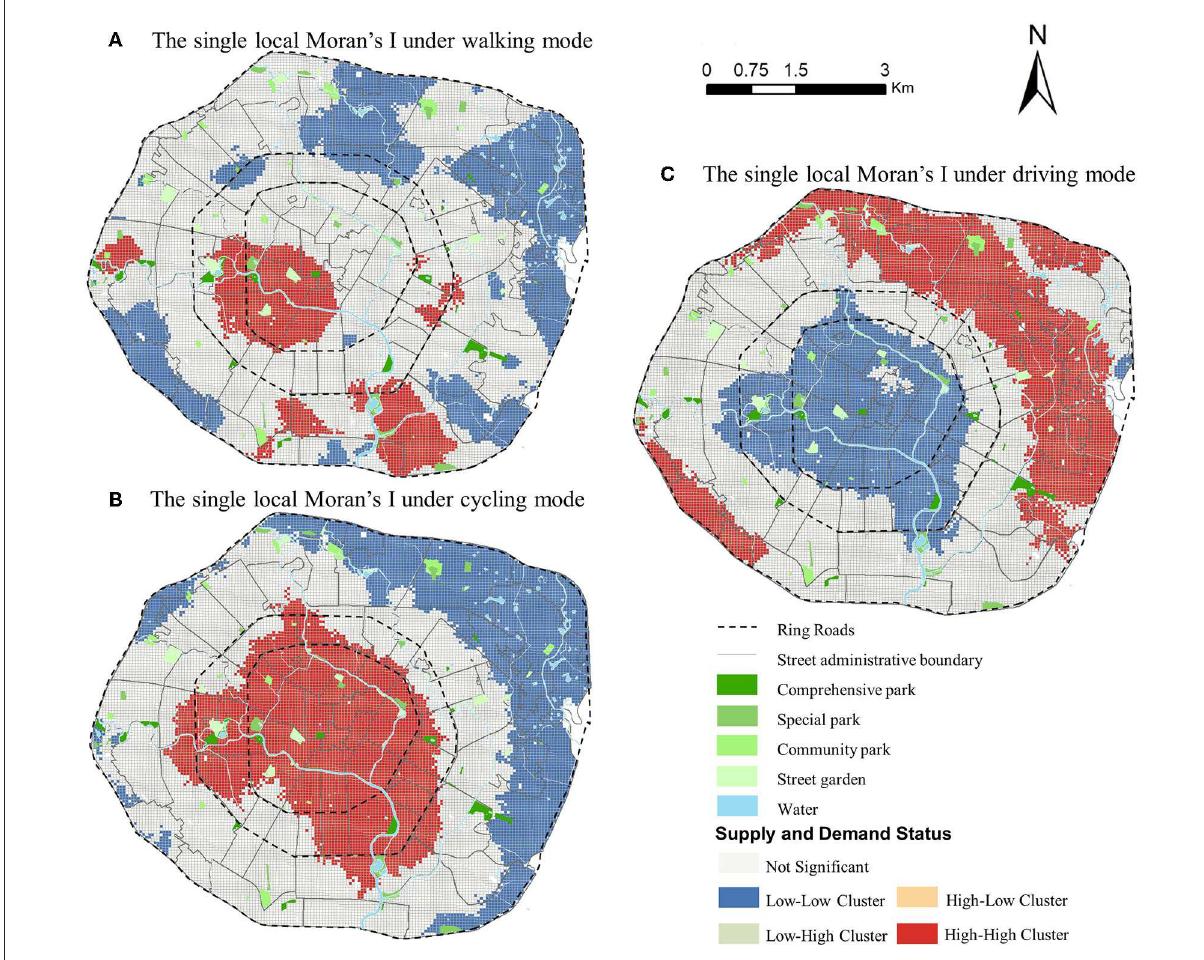
FIGURE11 Spatial autocorrelation analysis under different travel modes in Chengdu,